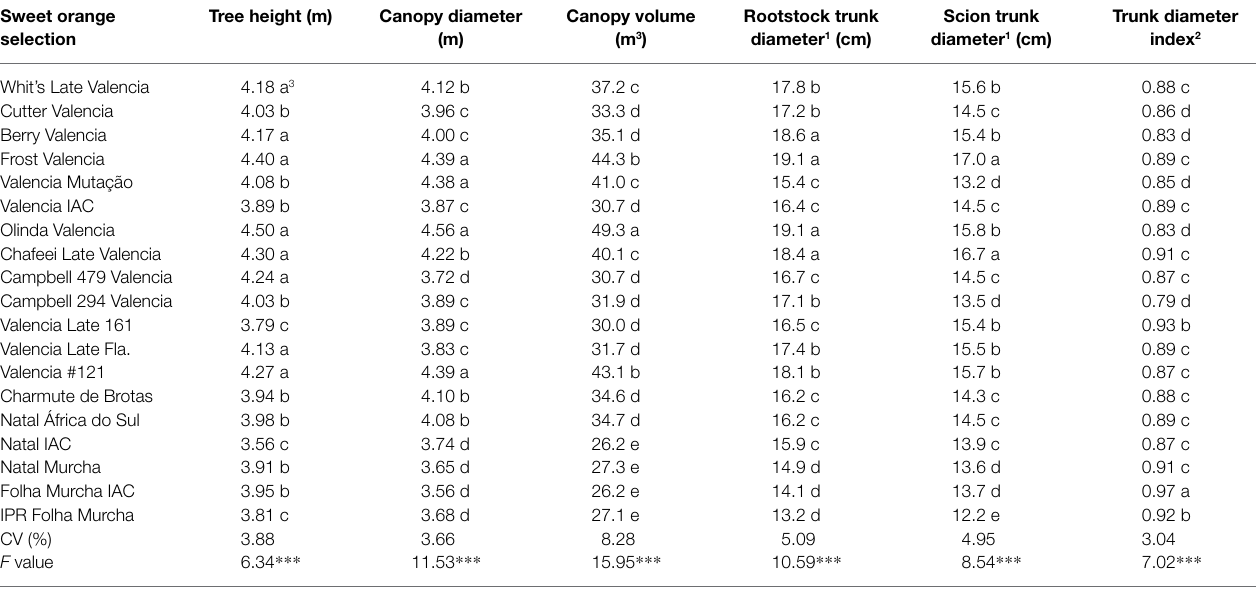
TABLE 2 | Tree size of 19 late-season sweet orange selections grafted onto Rangpur lime rootstock and determined in the 2019 season. Guairaçá, state of Paraná, Brazil. Sweet orange